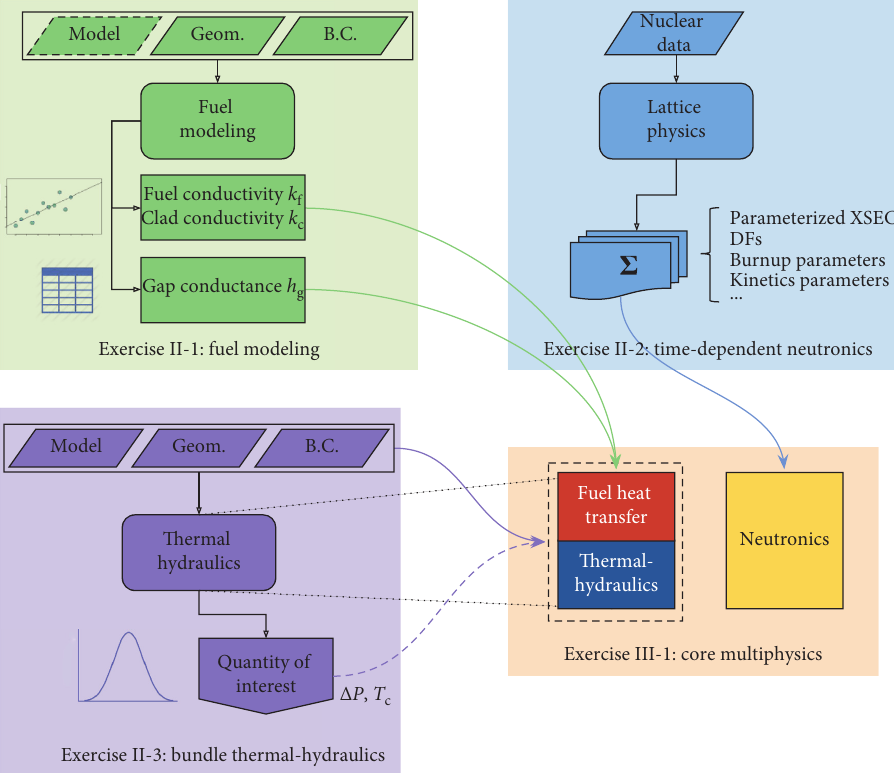
Figure 11: Interactions of Phase II and Phase III of the LWR UAM